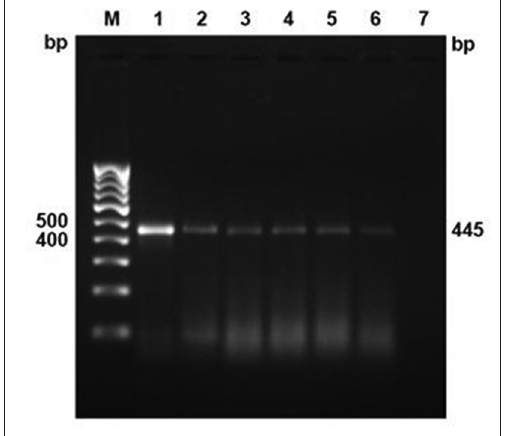
Figure-4: Direct polymerase chain reaction detection of Mycobacterium sp. in clinical samples (pre-scapular lymph node aspirates and milk) targeting IS 6110 sequence for members of Mycobacterium TB (MTB) complex at 445 bp.